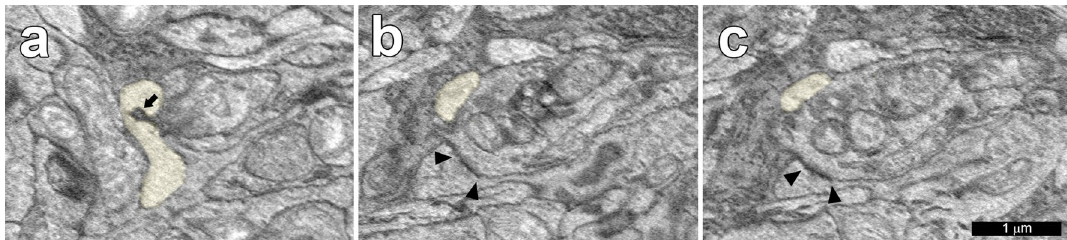
Figure 5. ( a ) Trogocytosis of OFF midget ganglion cell 50772 by microglial cell 50635 (yellow) ( b , c ) are consecutive sections through a synapse (arrowheads) onto the ganglion cell. ( a , b ) Separated by 4 70 nm horizontal